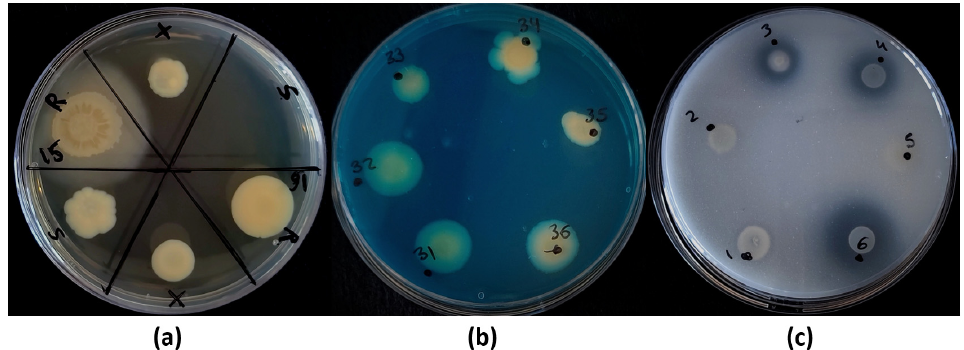
Figure 6. Petri dish-based screening methods. Plates prepared to discern ( a ) the main survival mechanism (LB plates); ( b ) siderophore production (Blue Agar CAS plates); and ( c ) solubilization of inorganic phosphate (NBRIP plates). In the first case, ‘R’ stands for regular or mock conditions (control); ‘X’, for the culture being resuspended in a full-desiccation process; and ‘S’, for the culture after thermal shock treatment. Strains were defined as sporulant if growth was detected in the ‘S’ section (as in strain 16 in the example plate); on the other hand, strains growing only in the ‘X’ section, but not in the ‘S’ section (as in strain 15 of the example plate), were considered to survive via the production of xeroprotective compounds (xerotolerant strains). Additionally, the growth ratios of the ‘X’ and ‘S’ treatments were compared to the control (‘R’) as an indirect way to evaluate the survival efficiency (see Table 3). In the second case, yellowish/orangish-stained colonies were considered positive in siderophore production (as in strains 34, 35 and 36 of the example plate); the staining halos around the colonies were measured (mm). In the last case, the solubilization halo around colonies was considered positive in phosphate solubilization (as in strains 3, 4 and 6 of the example plate).